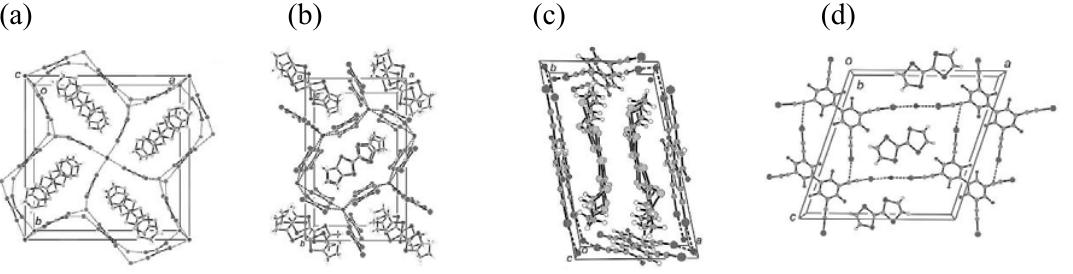
Figure 30. Crystal structures for (a) 1 , (b) 2 , (c) 3 , and (d) 4 . The dotted lines denote the “halogen bond” based on Lewis acidity of the neutral iodine atoms. [Reproduced with permission from [27] ACSNano 2008 , 2 , 143–155. ©2008, American Chemical